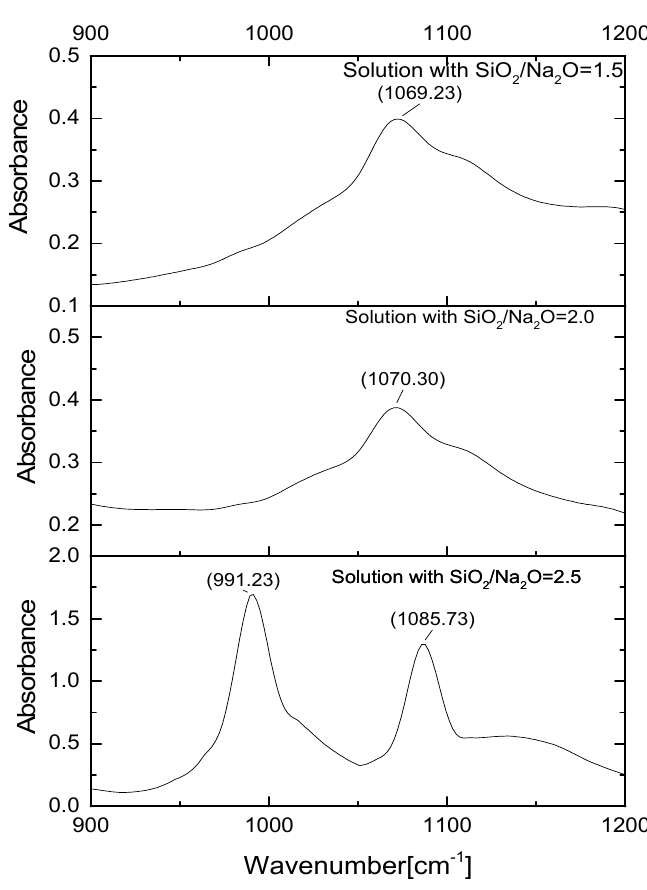
Figure 4. FTIR spectra of alkaline activators with different Ms.